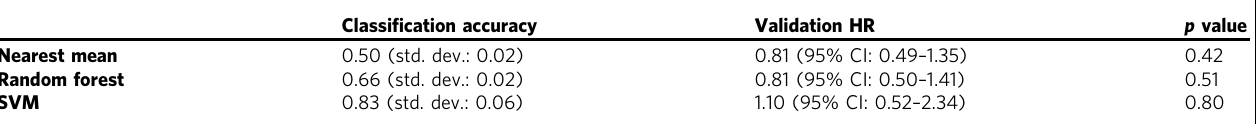
Table 2 Classi fi cation accuracy in cross-validation and HR in independent validation for the classi fi ers trained on labels selected from randomly generated classi fi cations with a signi fi cant HR under